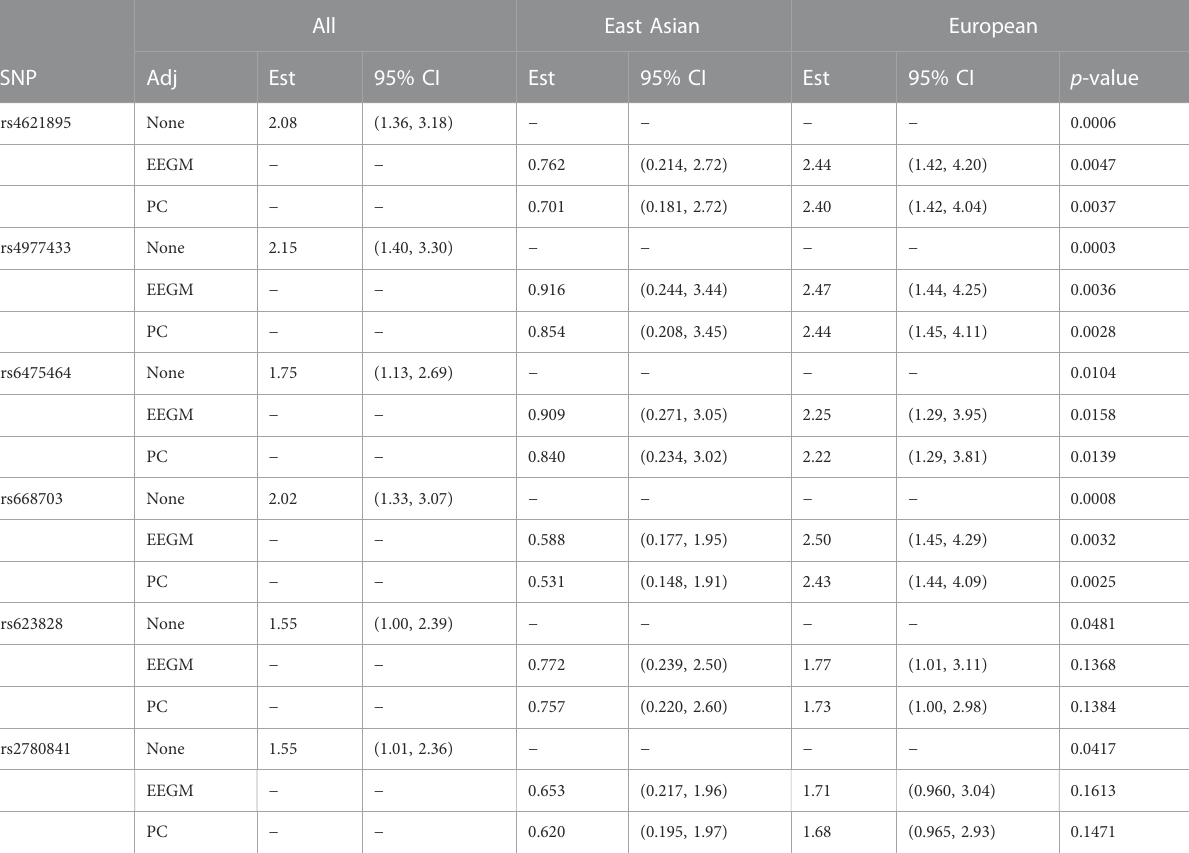
TABLE6EstimatedmodifyingeffectsofmaternalalcoholconsumptiononGRRs,95%con fi denceintervalsand p -valuesfromtheanalysisoftheGENEVAdata, atsixSNPsintheMLLT3gene(Chr9)showingsigni fi cantinteractionwithmaternalalcoholconsumptionin(Beatyetal.,2011).Estimates,con fi denceintervals andtests arebased on fi tting anadditive genetic model anduse (i)no adjustment, (ii) EEGMadjustmentor (iii) PCadjustment tocontrolfor exposure-related geneticstructureinthepopulation.Theunadjustedanalysisconsidersalltrioswithoutregardtogeneticstructure.TheEEGM-andPC-adjustedanalysesallow for genetic structure and we have reported estimates for hypothetical East Asian and European